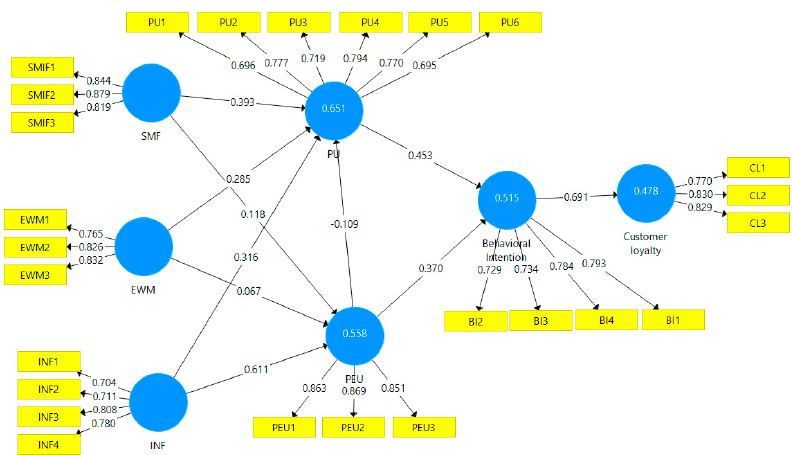
Figure 2. Path coe ffi cients.